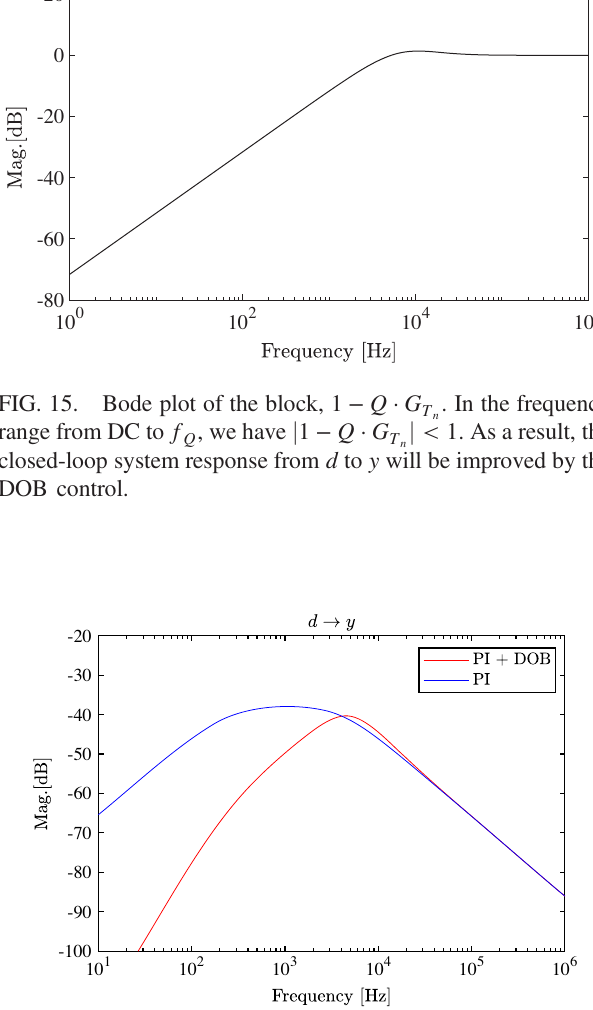
FIG. 16. Upper boundary for the singular values of the closed- loop transfer functions from d to y in the cases of the two different control strategies.